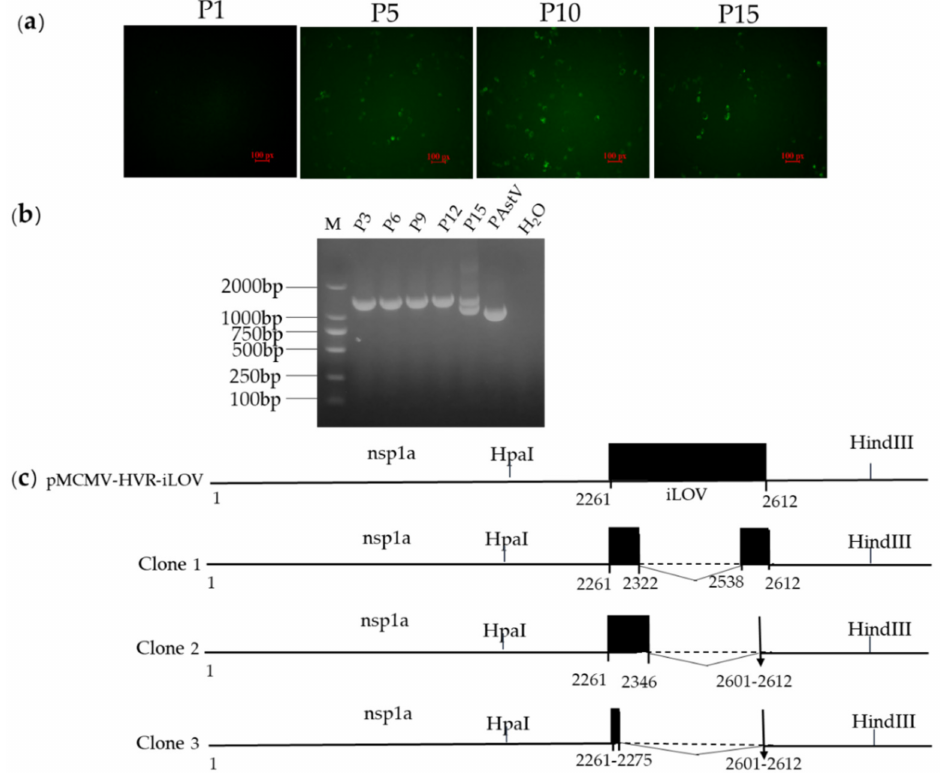
Figure 7. ( a ) Analysis of the stability of reporter genes in the genomes of recombinant viruses in cells. Expression of reporter auto-fluorescence during serial passages of reporter viruses. PK- 15 cells were infected with P1, P5, P10, and P15 viruses. At 24 h.p.i, live cells were imaged with a fluorescent microscope. ( b ) Agarose gel pictures showing the DNA fragments covering the reporter gene as generated by RT-PCR using the RNA extracted from cells infected with P3, P6, P9, P12, and P15 viruses. ( c ) The boundaries of the nucleotide deletions detected in the reporter gene of passaged viruses. Internal deletions were found in the genomes of passaged viruses. The numbers below the boxes indicate the nucleotide boundaries of the inserts and the internal deletions. The deleted regions are indicated by the dotted